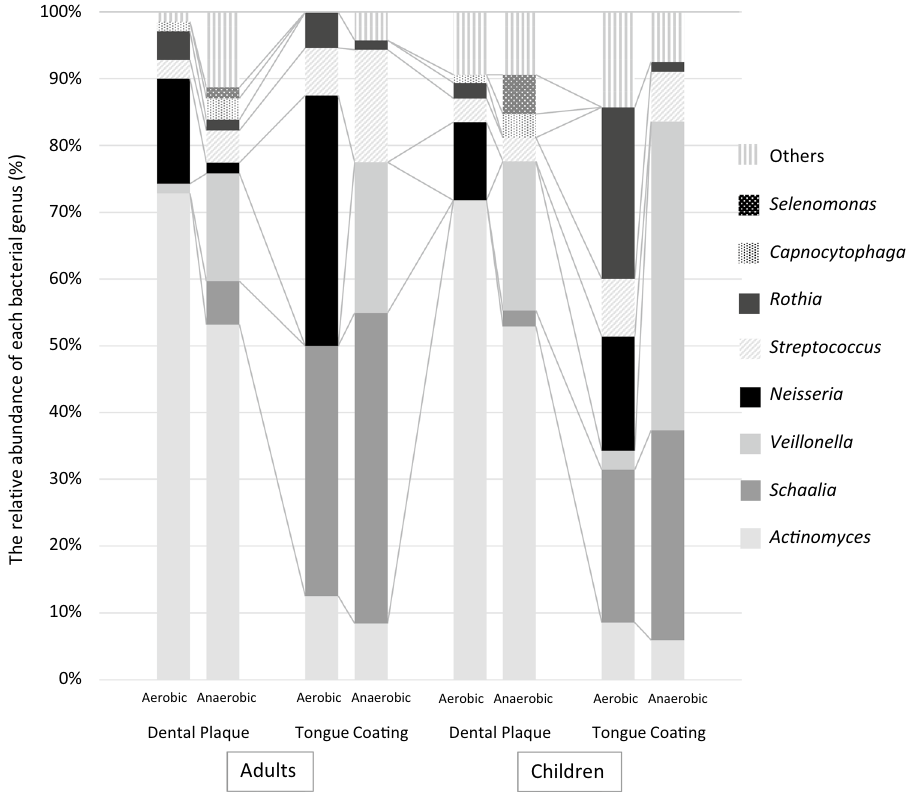
Figure 5. The proportion of NO 2 − -producing bacterial genera identified in the dental plaque and tongue coating samples from adults and children. All data were adopted from Table